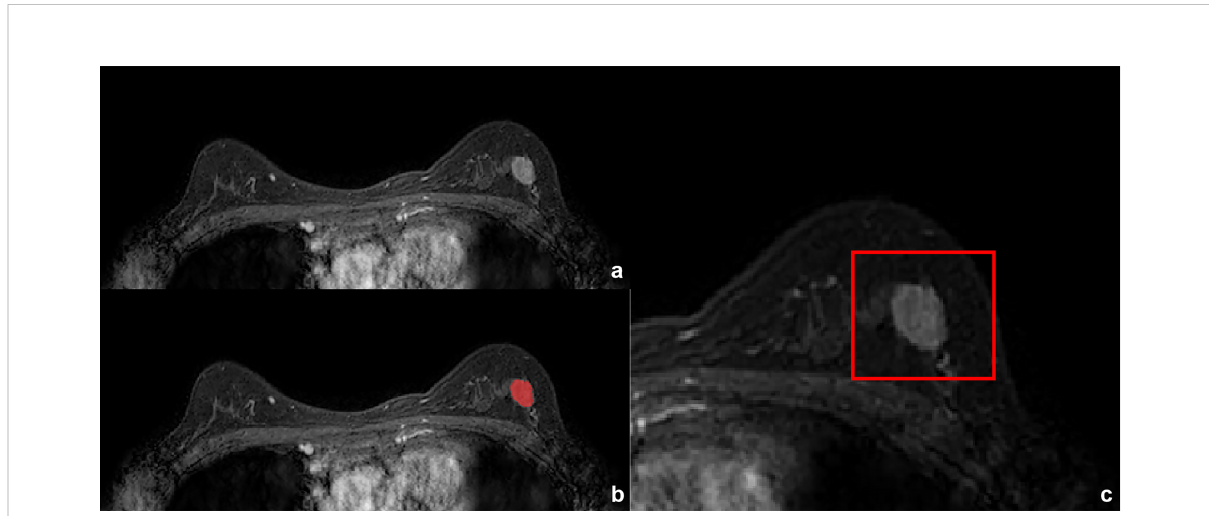
FIGURE 2 Invasive breast cancer in a 57-year-old woman. (A) T1-weighted postcontract image. (B) Annotation masks (in red) are superimposed over the MR images. The annotations were made by radiologists using ITK-snap. (C) The anchor box was generated by the Faster R-CNN model after the